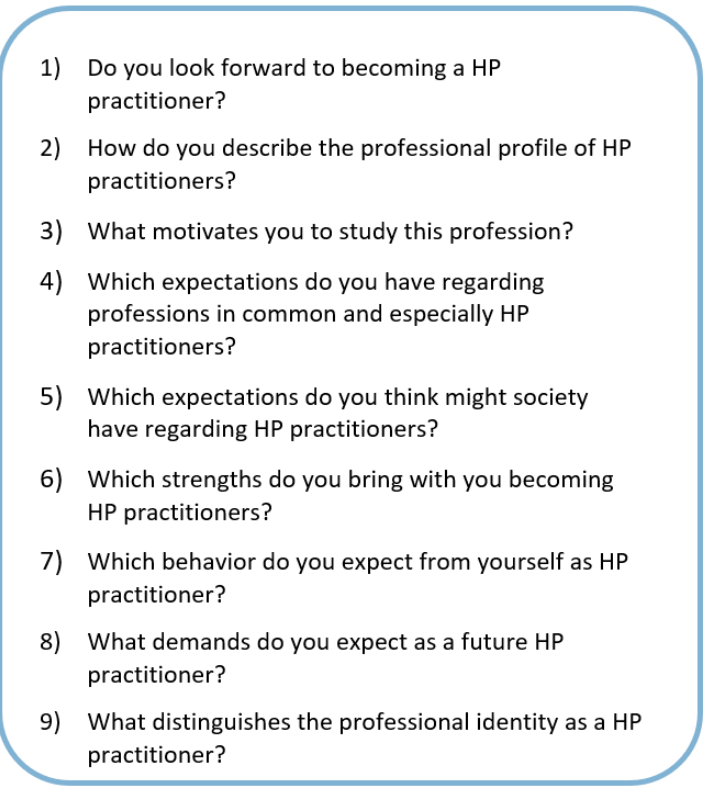
Figure 1. Interview guide of theory-based core questions for focus groups analyzing professional identity formation of undergraduate students in health promotion and prevention.